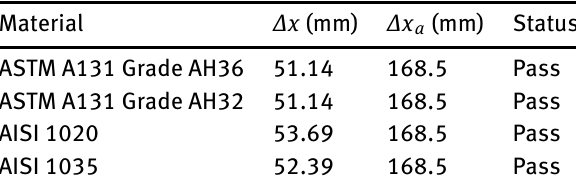
Table 3: Material deformation simulation results. Material